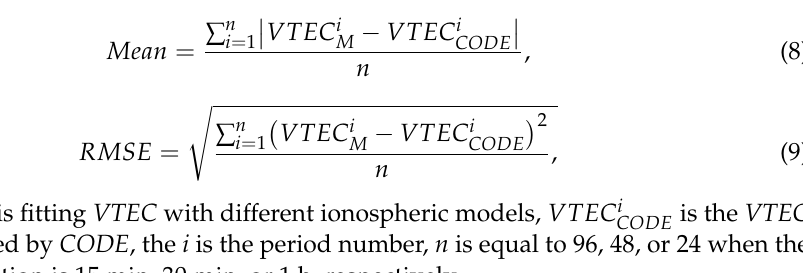
Table 4. Accuracy statistics of three ionospheric models on the disturbance and quiet day (unit: TECU). Mean RMSE SH Pliynomial ICE SH Pliynomial ICE 15